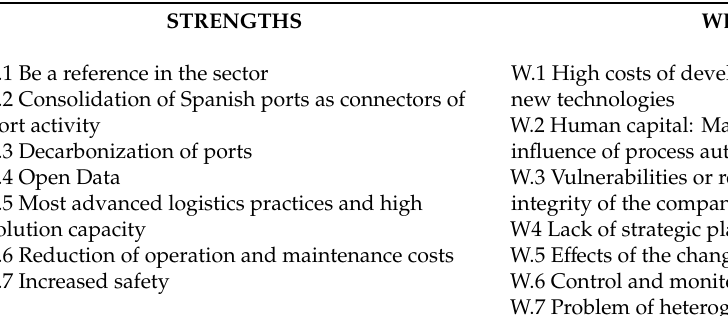
Table 2. Elements of maximum consensus of SWOT Matrix (written in